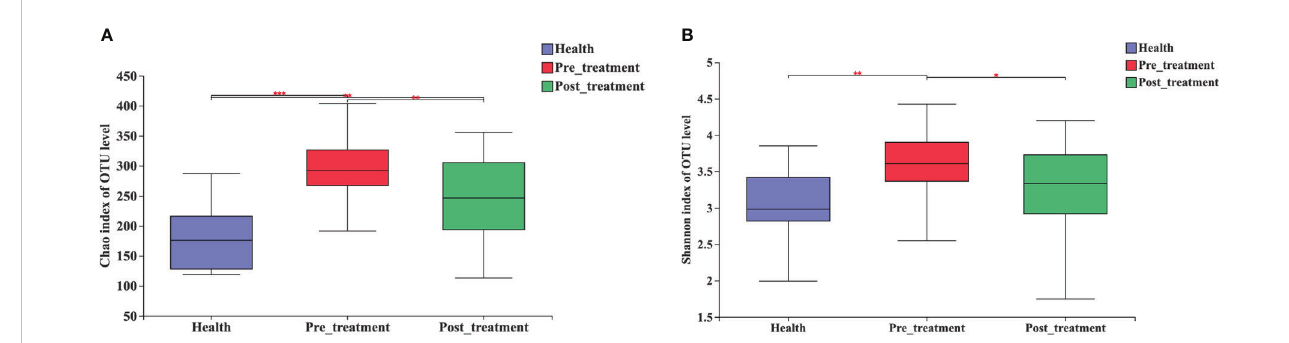
FIGURE 2 Alpha diversity estimates for the microbial pro fi les in the healthy, pre-treatment, and post-treatment groups. (A) Microbial richness presented by Chao1. (B) Microbial diversity presented by Shannon. *** p < 0.0001, ** p < 0.01, * p < 0.05 by Wilcoxon rank-sum